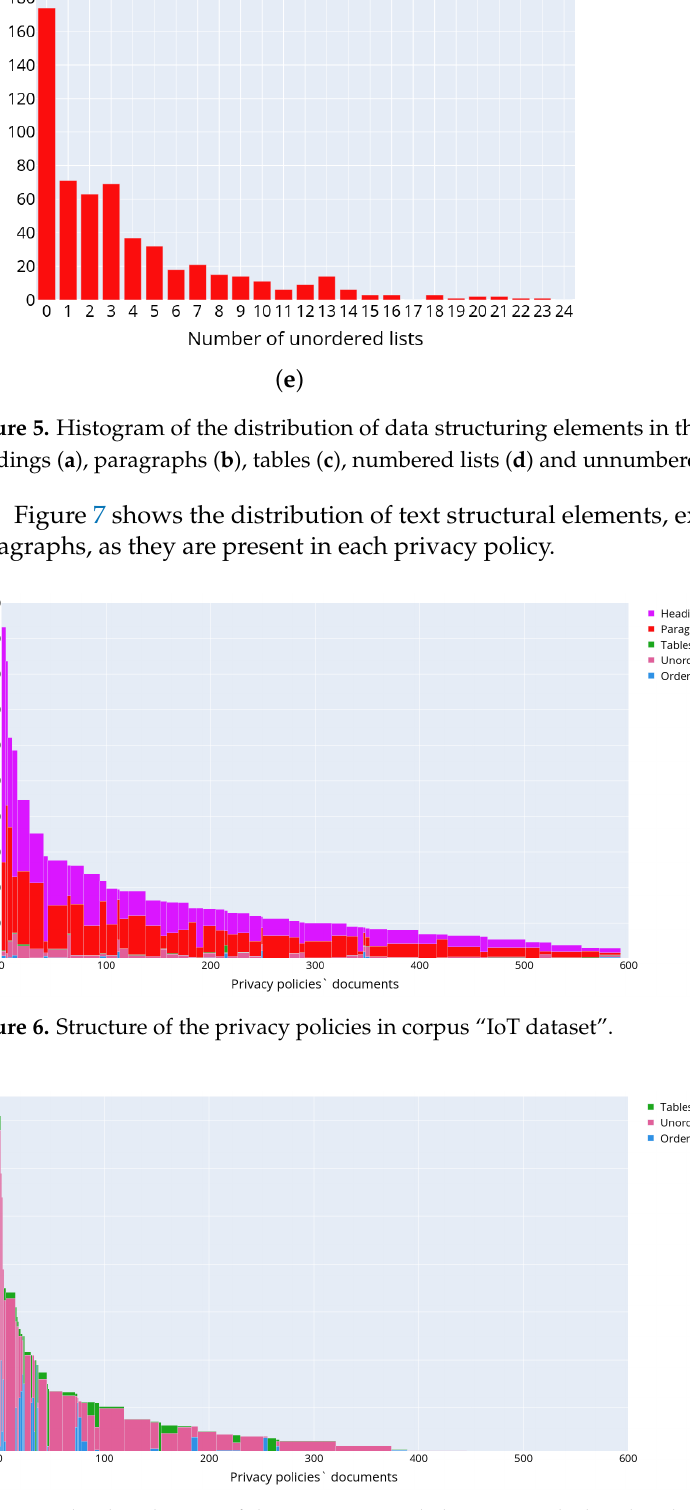
Figure 7. The distribution of the text structural elements excluding headings and paragraphs in the privacy policies in corpus “IoT dataset”